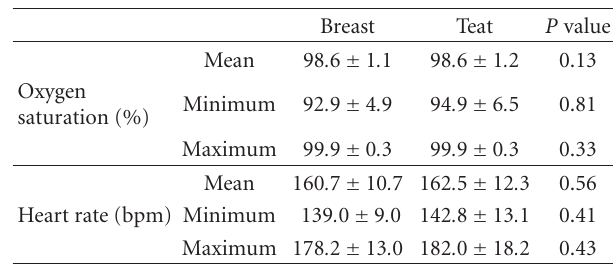
Table 1: Feeding characteristics for the monitored breastfeed and the feed from the experimental teat.